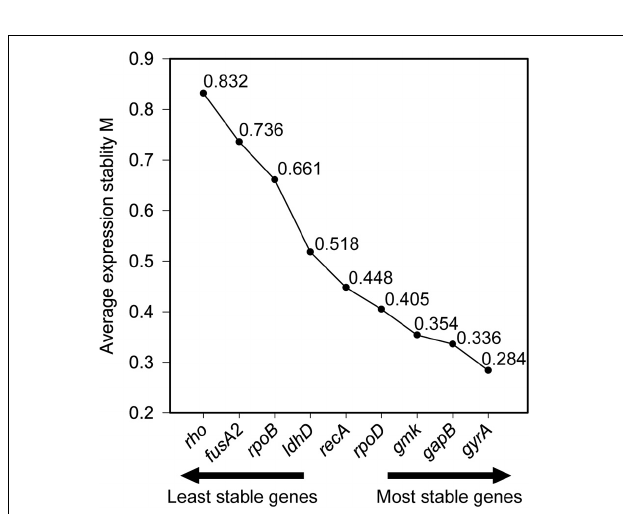
FIGURE 4 | Average expression stability of reference genes calculated using geNorm.